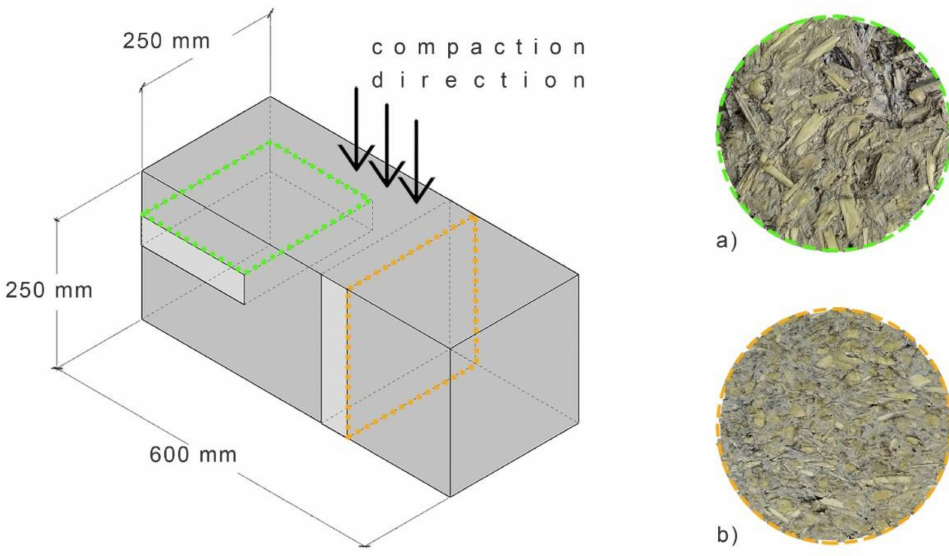
Figure 2. The method of cutting out samples for testing the thermal conductivity coefficient, ( a ) THS ⊥ ( b ) THS II.